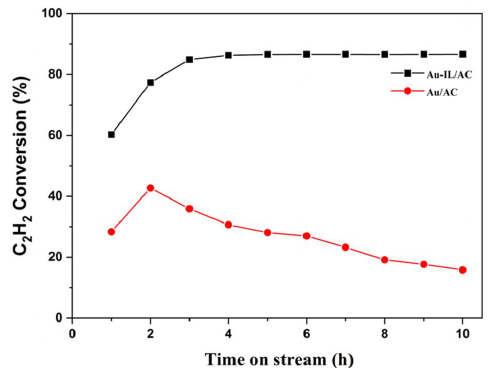
Figure 1. Comparison of catalytic performance between 1 wt.% Au-IL/AC and 1 wt.% Au/AC. Reaction conditions: T = 463 K, GHSV (C 2 H 2 ) = 370 h -1 , V(HCl)/V(C 2 H 2 ) = 1.2. The standard deviations (SDs) for the black and red data are 8.43 and 8.36, respectively.